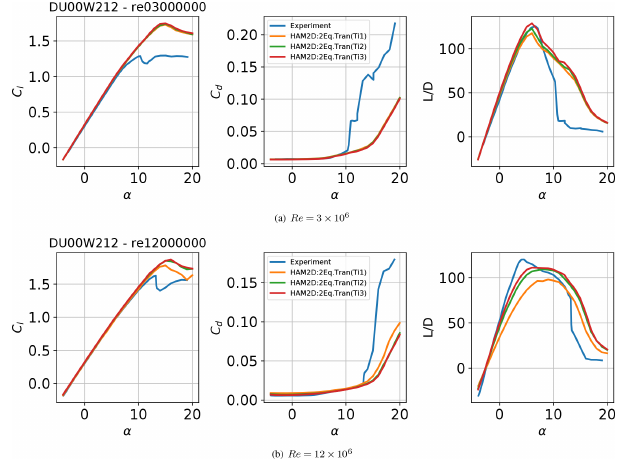
Figure 10. Sensitivity of the predictions from HAM2D using the two-equation transition model to the free-stream turbulence inten- sity (Ti1, Ti2, Ti3) at two Reynolds numbers Re = 3 , 12 × 10 6 , as defined in Table 2.